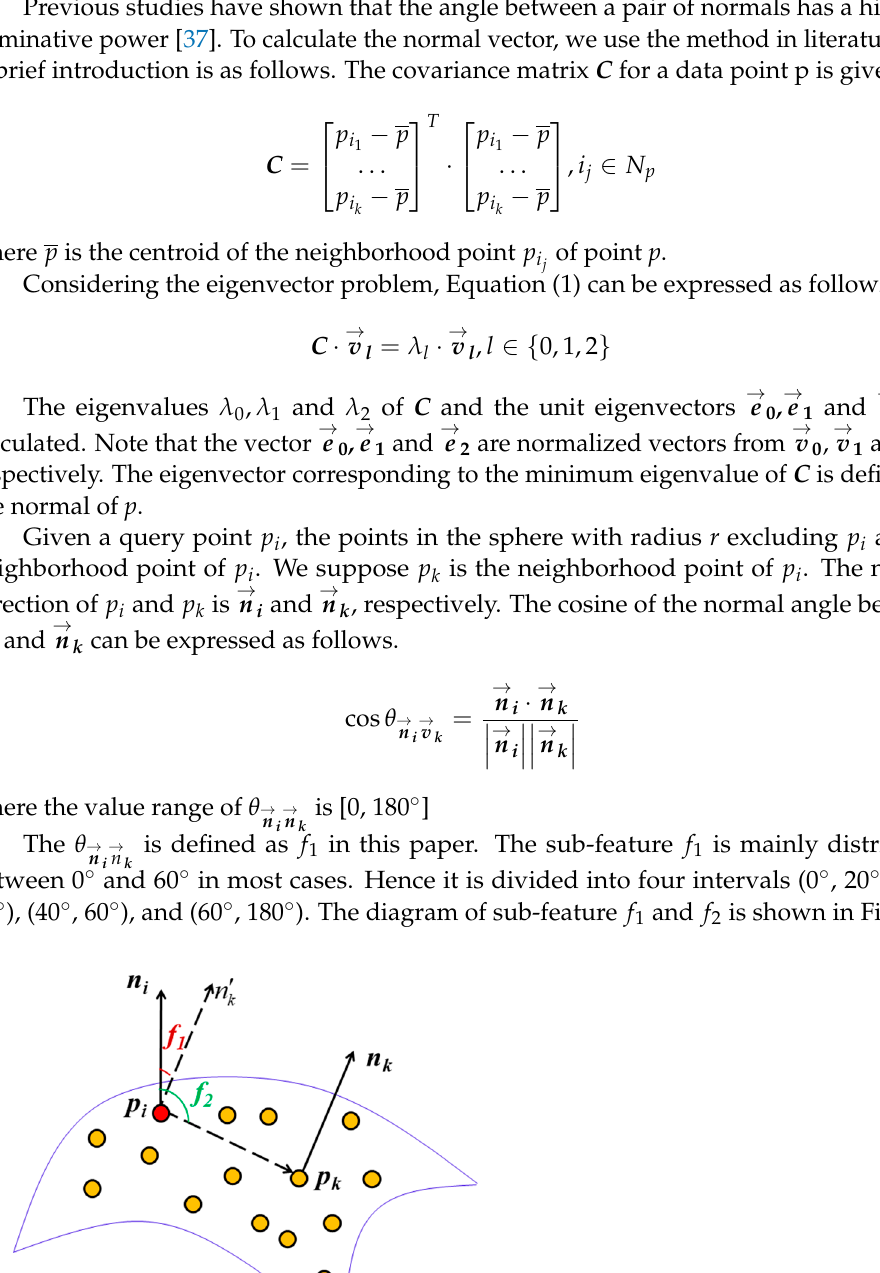
Figure 2. The diagram of sub-feature